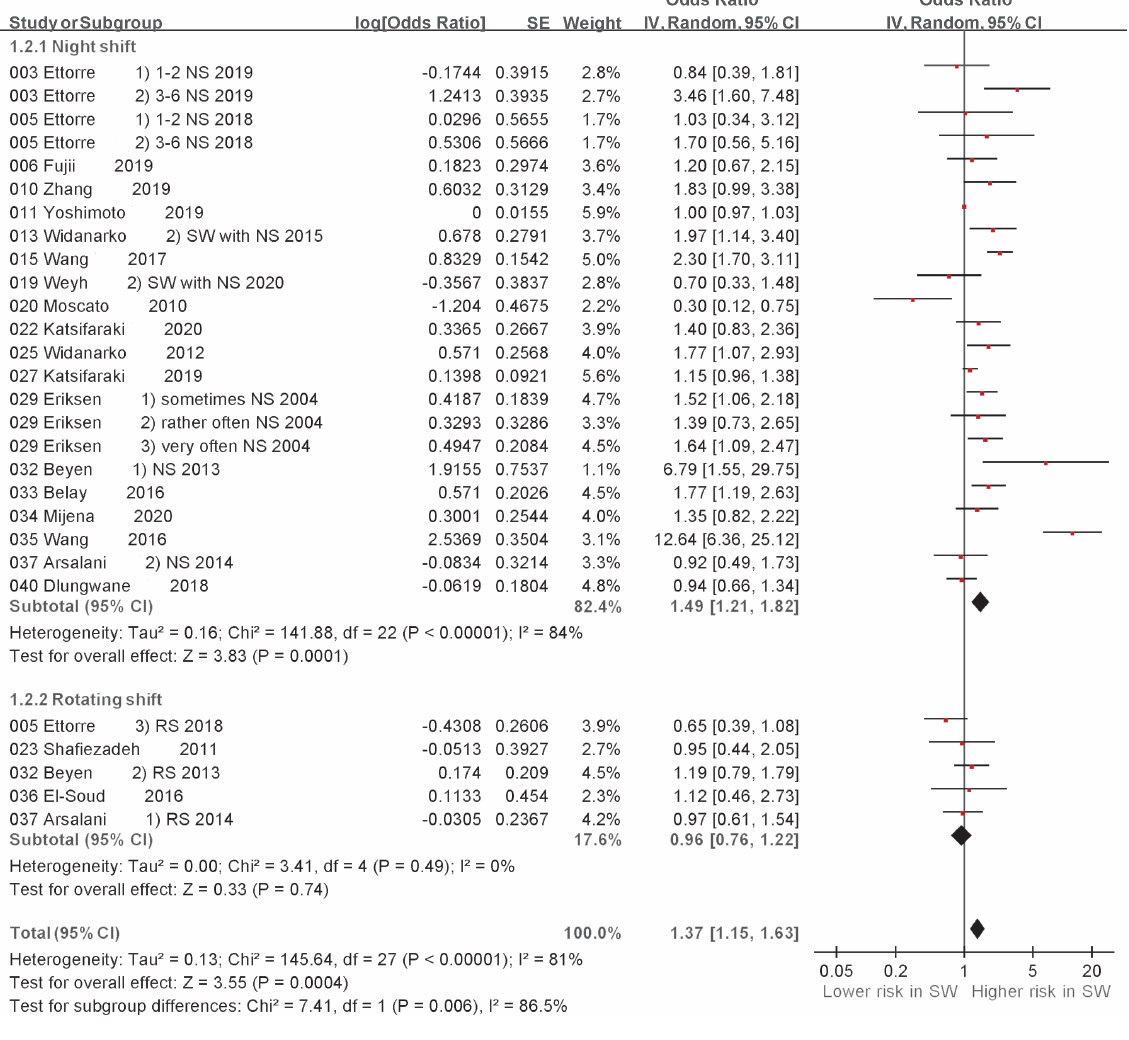
Figure 4. Figure 4. Subgroup analysis of odds ratio of low back pain based on night shift or rotating shift. CI, confidence interval; SE, standard error